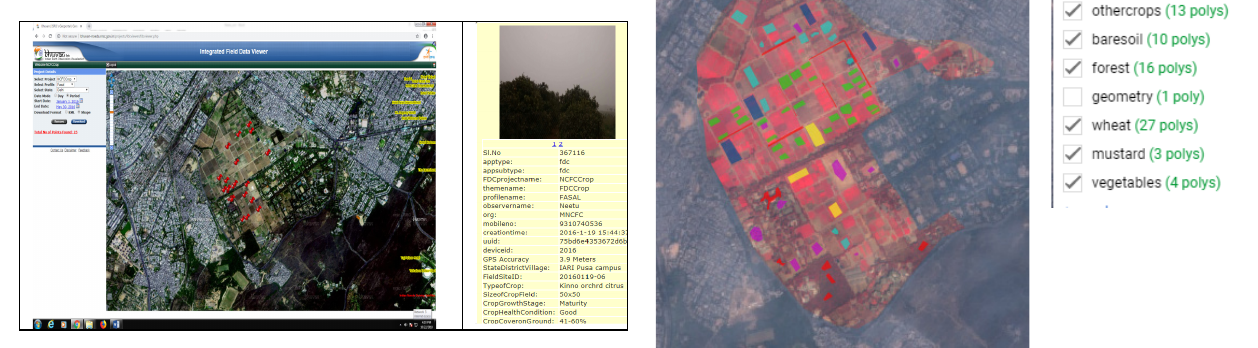
Apart from this, Sentinel -2 data (5 Feb 2016) was classified,